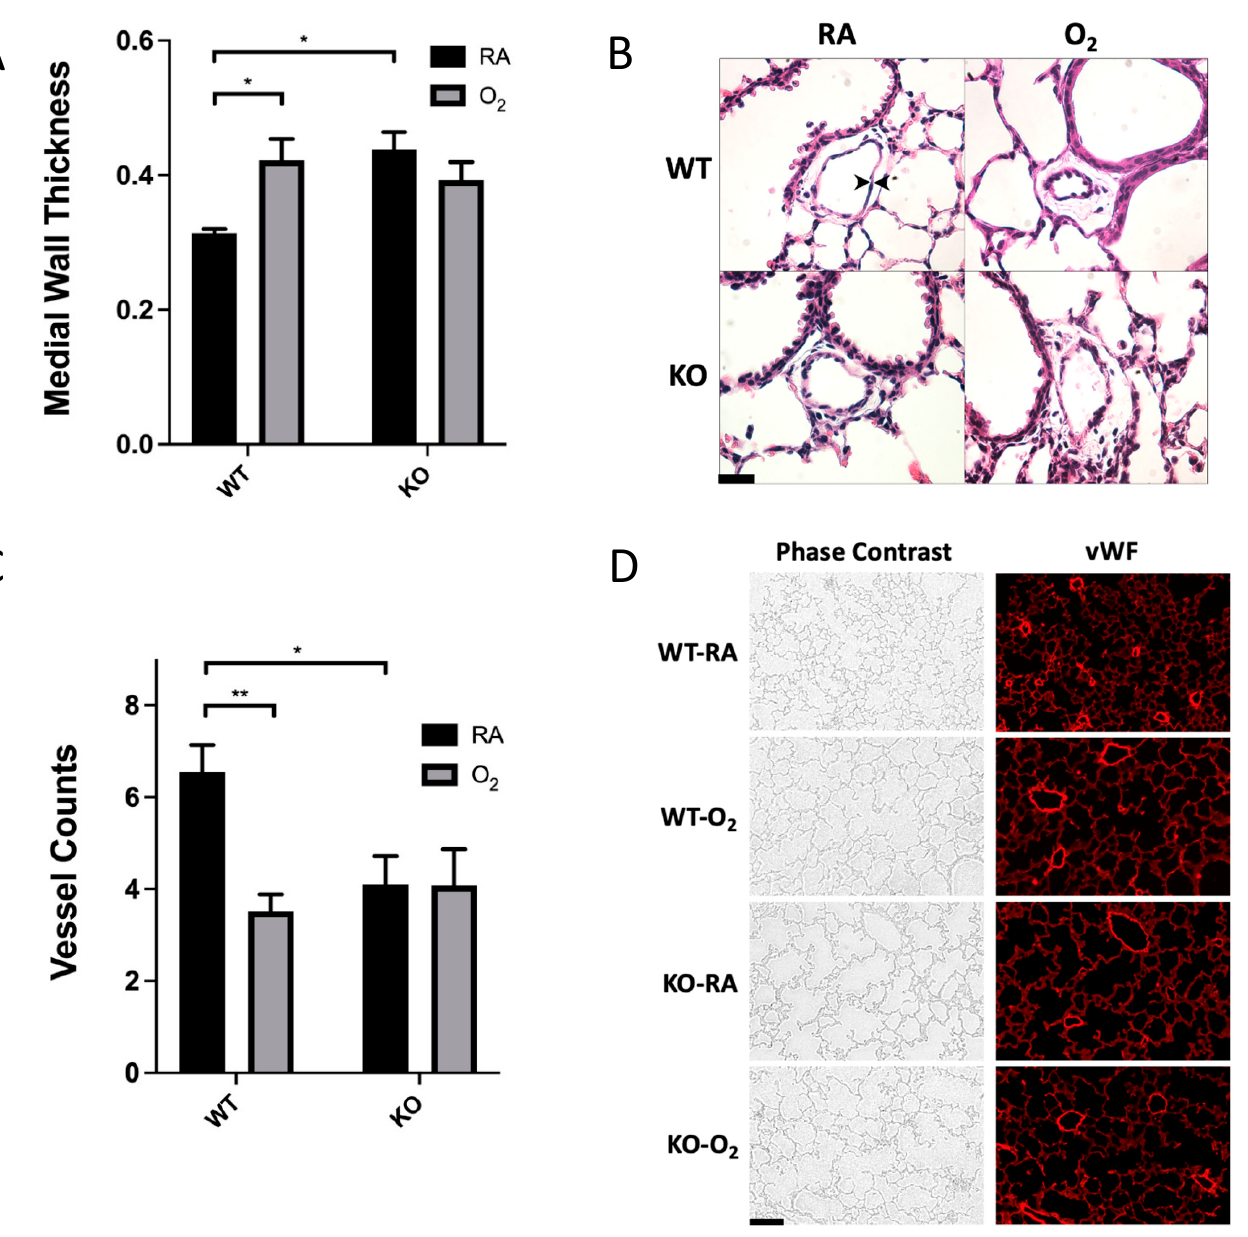
Figure 2. Hyperoxia exposure and SOD3 KO alone induced microvascular remodeling, but there was no additive effect of genotype and exposure. ( A ) Lung sections were analyzed at 40 × magnification. Cross-sections of peri-bronchiolar arterioles were identified for analysis. Medial wall thickness was significantly higher in O 2 -exposed mice in the WT genotype but not the KO genotype; n = 5–7. ( B ) Representative high-power (40 × ) images of H&E-stained cross-sections of peribronchiolar pulmonary arterioles. Arrowheads indicate the medial layer. Scale bar is 20 µ m. ( C ) Lung sections were stained with vWF antibody to highlight the vascular endothelium. Vascular density was analyzed by counting resistance pulmonary blood vessels (<100 µ m diameter) per low-power (10 × ) field. Vessel counts were significantly lower in O 2 -exposed mice compared to RA in the WT genotype but not the KO genotype. ( D ) Representative low-power (10 × ) images of phase-contrast and immunofluorescent lung are presented. Scale bar is 100 µ m. Data are presented as means ± SEM; * p < 0.05, ** p < 0.01.